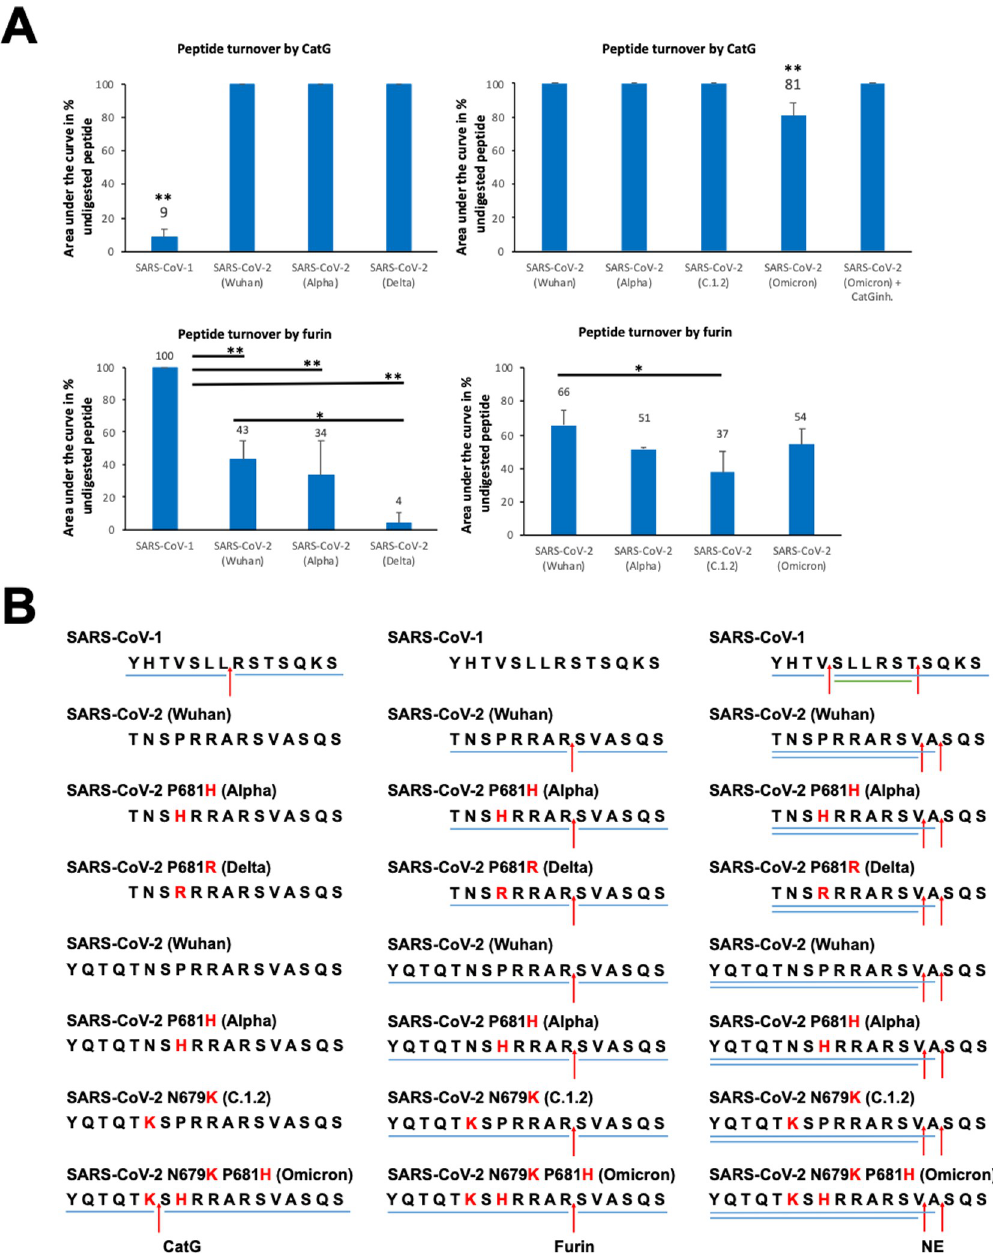
Fig 3. Proteolytic cleavage sites within the polybasic sequence of the proteolytically sensitive activation loop. A) The peptides (200 μ g/ml) were incubated with 4 μ g/ml of the respective protease for 2h at 37˚C and followed by quantification of the peptide turnover by using HPLC. Of note, quantification of substrate (SARS-CoV-2 variants) turnover by NE was not completely feasible due to the fact that the undigested peptide and the digestion pattern migrated on the same HPLC peak. The summary of substrate turnover by CatG (SARS-CoV-2 Omicron, n = 5) or furin (n = 3) is shown in a bar diagram. P < 0.05 ( � ) or P < 0.01 ( �� ). CatG inhibitor = CatGinh. B) Catalytic cleavage sites of CatG, furin, and NE are summarized. Red arrows indicate cleavage sites and blue bars the digestion pattern (peptides) detected by mass spectrometry. Of note, green bars represent less prominent peptides. CatG, furin, and NE at least n = 2 independent experiments.